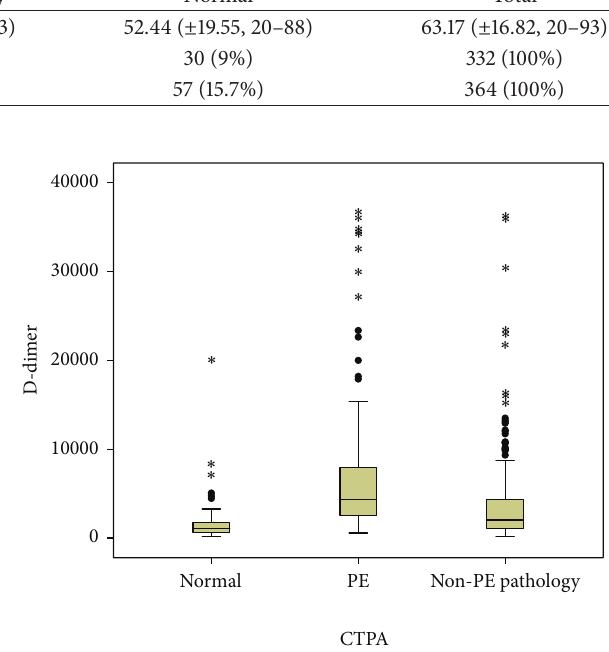
Figure 1: Independent samples Kruskal-Wallis